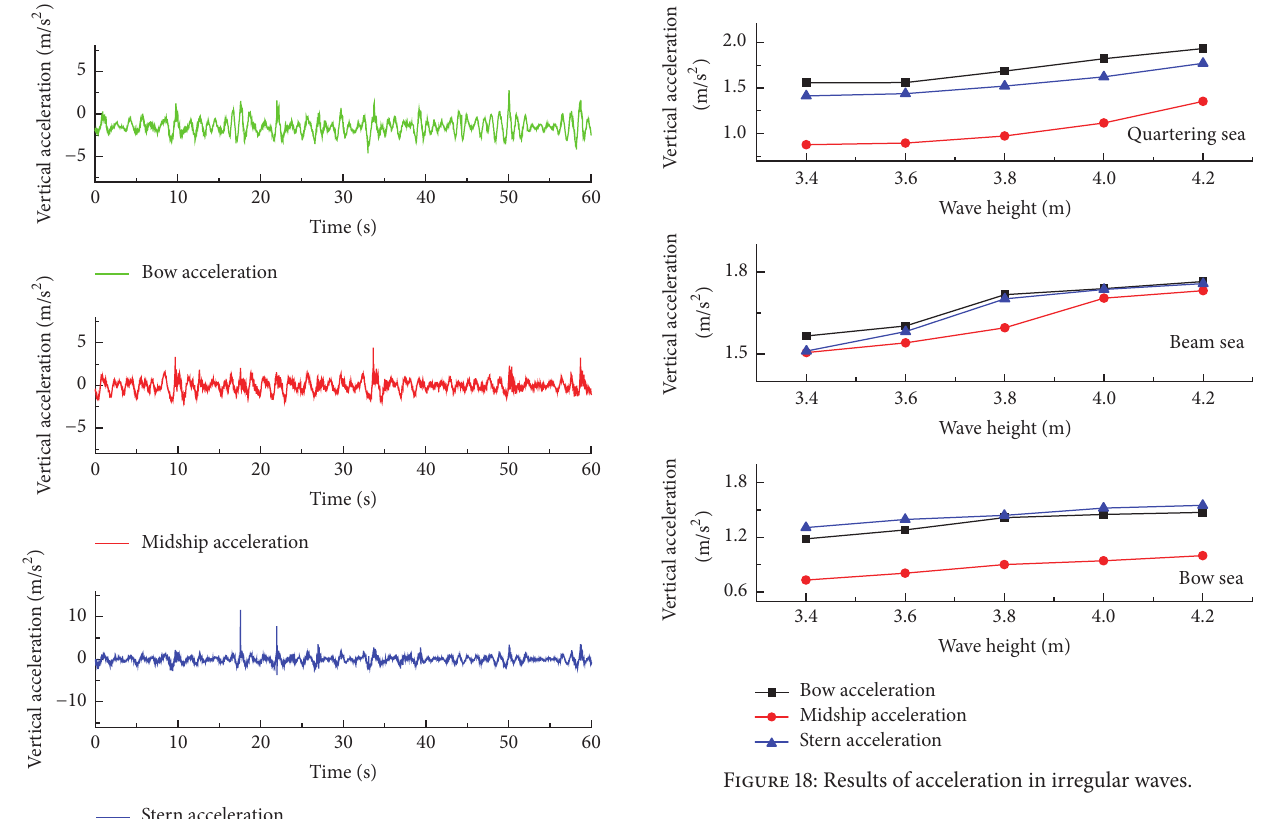
Figure 17: Time histories of acceleration in beam sea.